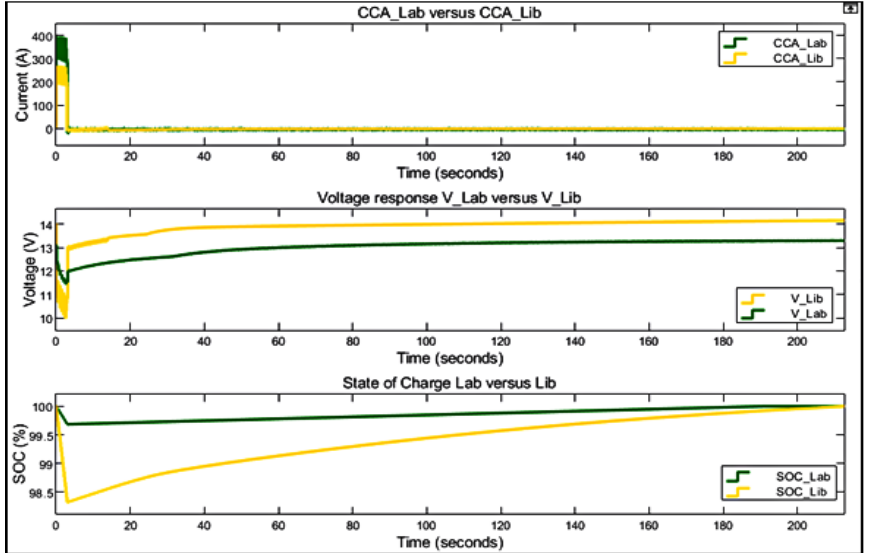
Figure 20. The CCC, SoC and voltage response of HESS during charging mode for case three (a).